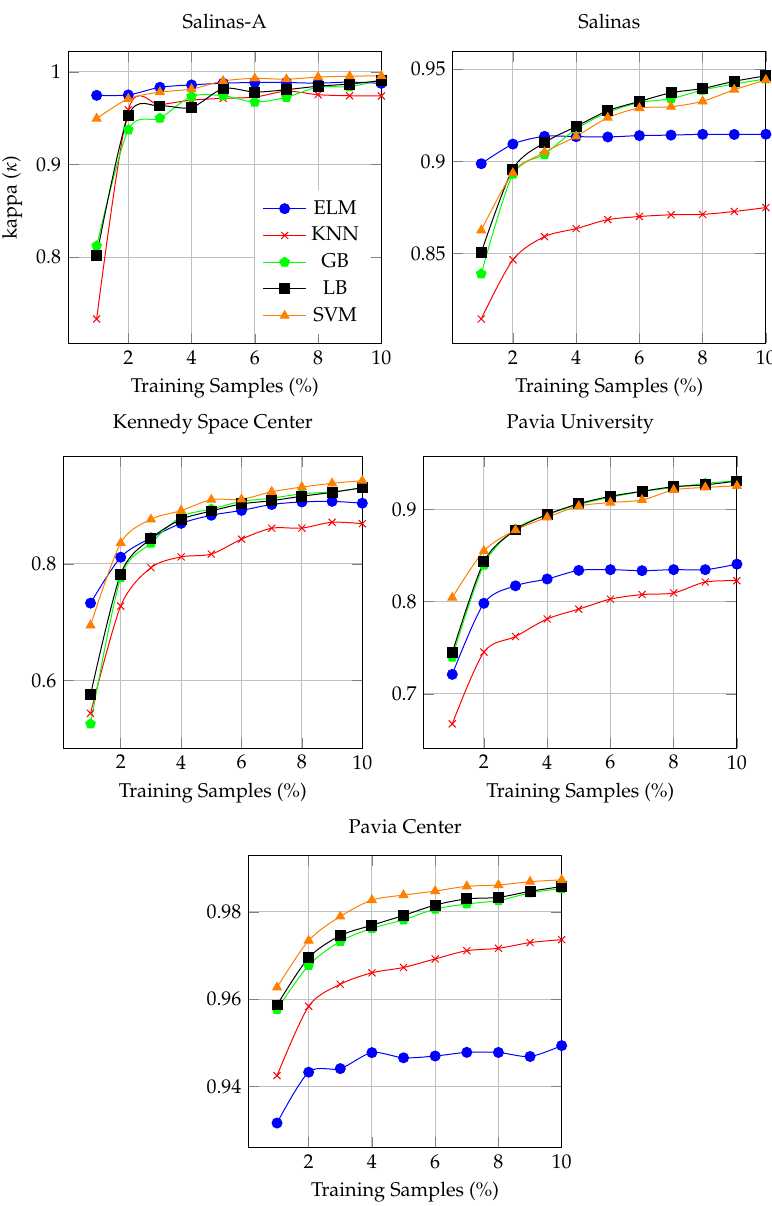
Figure 4. Kappa ( κ ) accuracy with different number of training samples (%) selected in each iteration from Salinas-A, Salinas, Kennedy Space Center, Pavia University, and Pavia Center